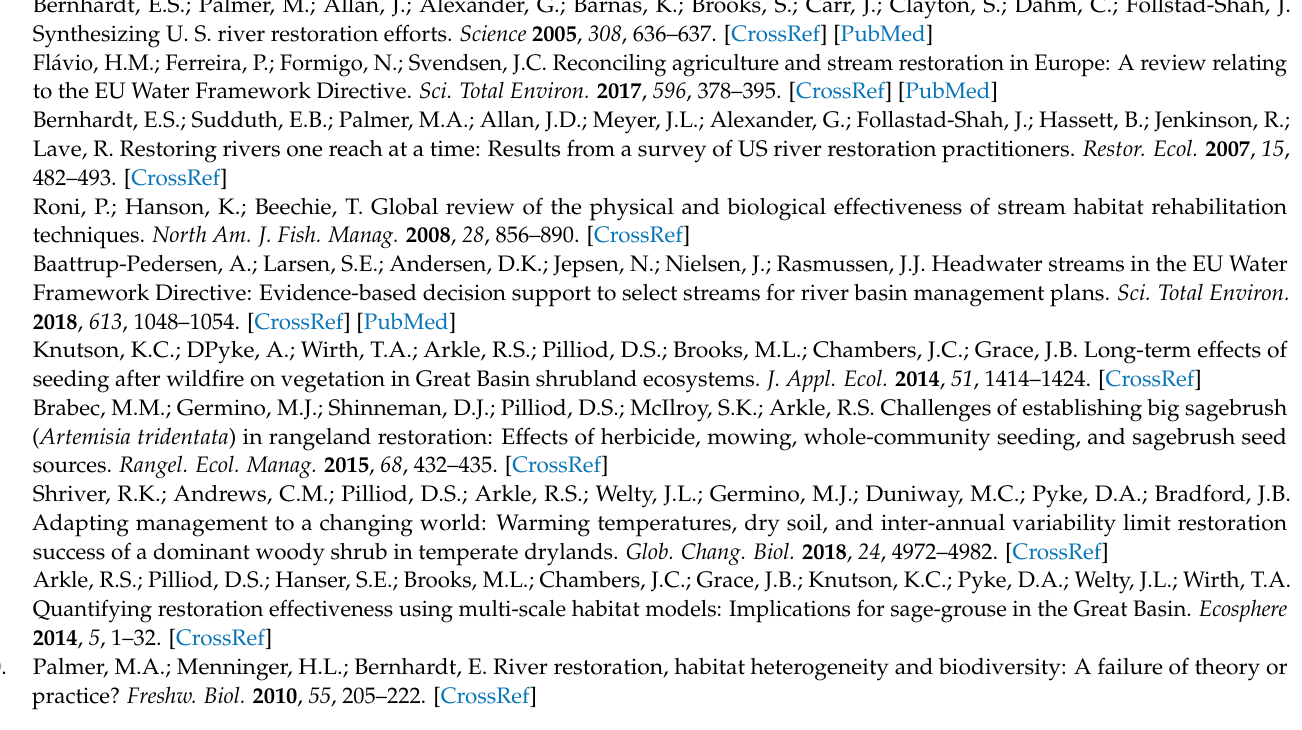
Figure A5. Cyanobacteria colonies ( Nostoc parmelioides ), each containing a Chironomid larva, growing on the surface of a cobble from the LH-reach. The upper surface of the rock was exposed to the current, whereas the lower half was embedded in other cobbles and sediment. Each disk-shaped colony is approximately 1 cm diameter. No other macroinvertebrates were removed prior to the photograph being taken, yet few if any, are visible. Photo by David Pilliod.